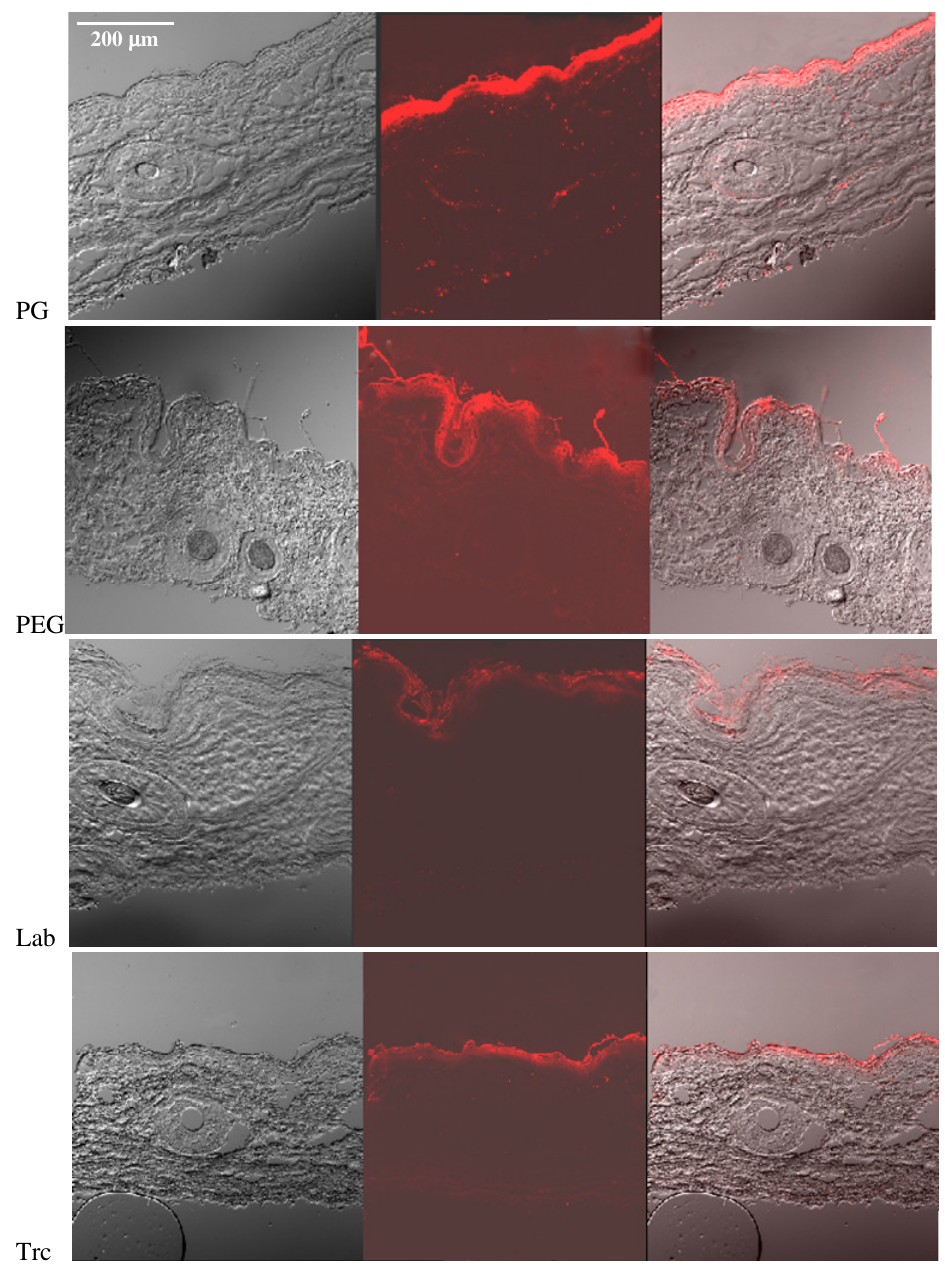
Figure 5. CLSM of cross-sections of new born pig skin treated for 8 h with PEVs labeled with rhodamine-phosphoethanolamine. PG, PEG, Lab and Trc were used to formulate PEV